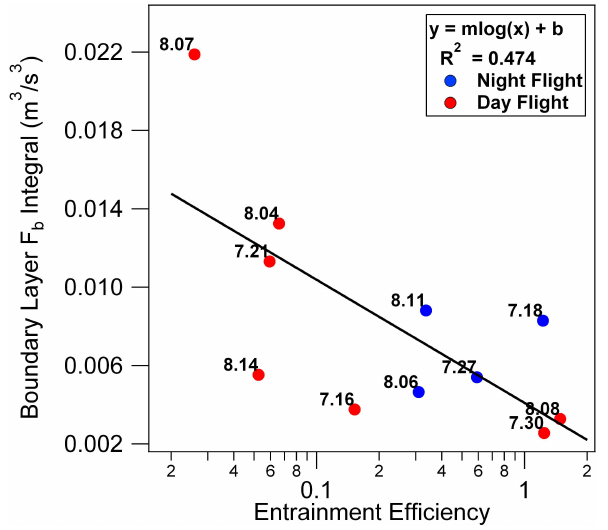
Fig. 9. Scatter plot of the entrainment efficiency η versus the bound- ary layer integral (i.e. R + F b from Eq. 6). Each point is the average value for the flight, with the corresponding date beside each point, and color denoting day and night flights.